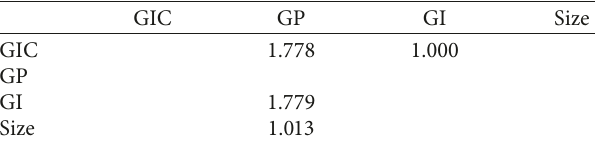
Table 6: Analysis of collinearity in the model through VIF